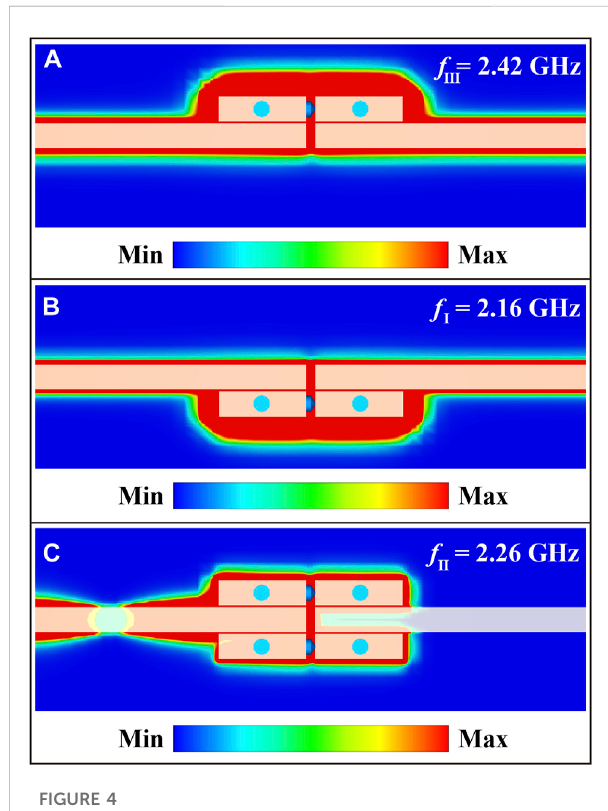
FIGURE 4 The simulated electric energy density distributions in (A) the individual upper ZIM-based meta-atom, (B) the individual lower ZIM- based meta-atom, and (C) the combinative SEC-like